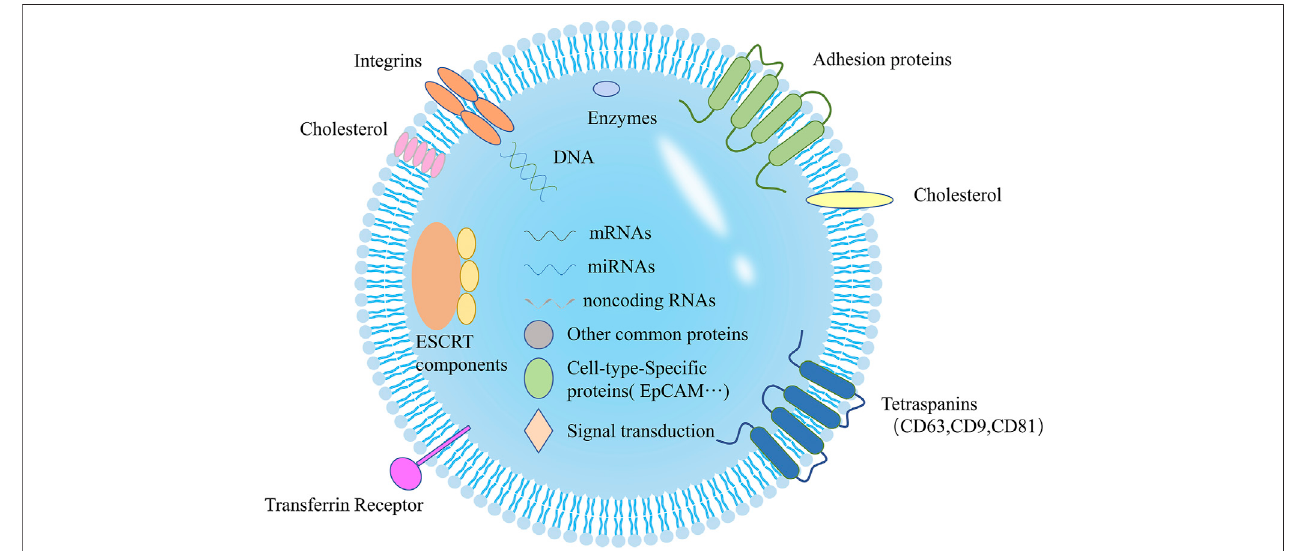
FIGURE 3 | Schematic of exosomal molecular composition. Exosomes contain various important biomarkers, such as proteins, lipids, and miRNAs.